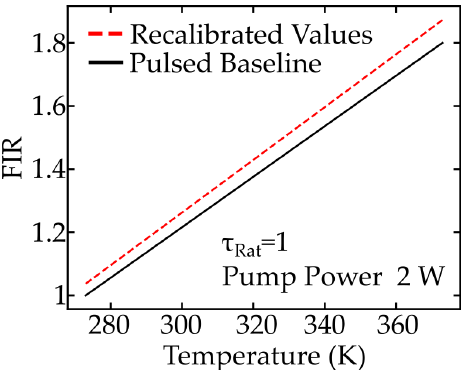
Figure 8. Typical FIR evolution for Pr:YLF nanothermometers [7] measured with pulsed excitation in black and the re-calibrated version determined by applying the correction factor